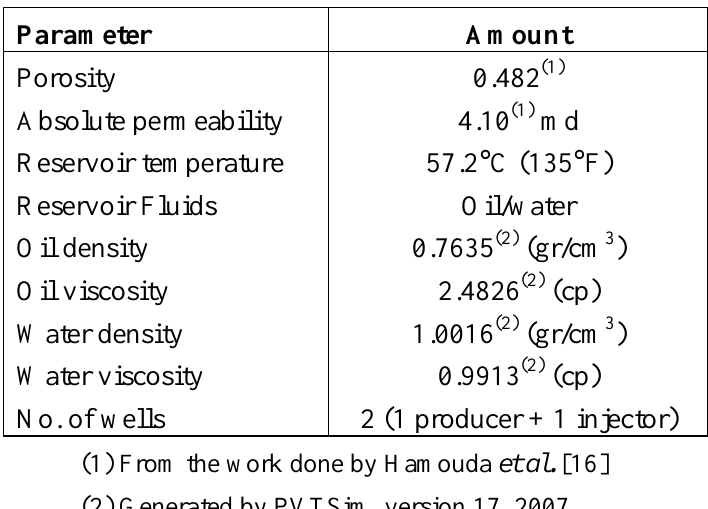
Table 6. Reservoir model input